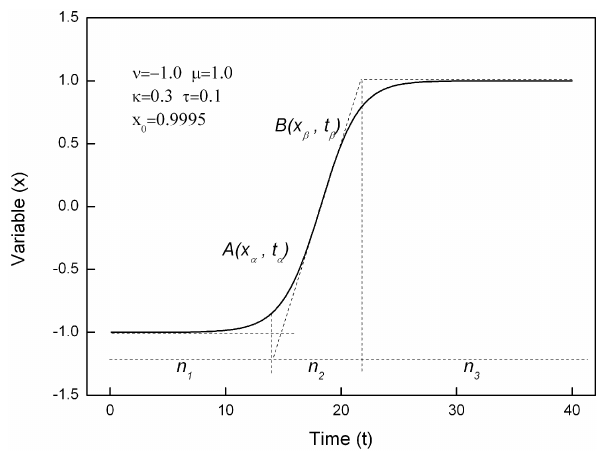
Figure 3. The abrupt change process and its sections. The three sections are as follows: period before the abrupt change, period of abrupt change process, and period after abrupt